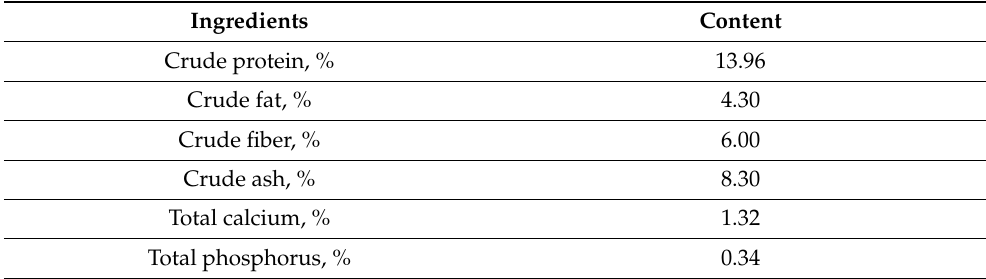
Table 1. Nutrient composition of mulberry leave powder (MLP).